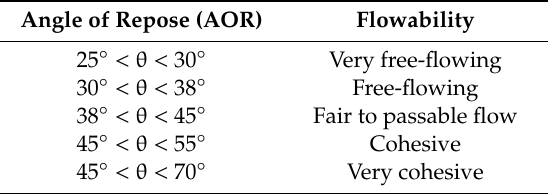
Table 4. Classification of powder flowability by AOR